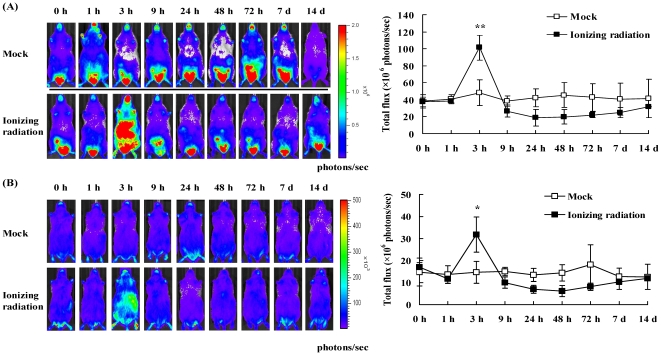
NF-κB-dependent bioluminescence in living mice.Transgenic mice were exposed to ionizing radiation and imaged in ventral (A) and dorsal positions (B) at indicated periods. In vivo imaging was shown on the left panel. The color overlay on the image represents the photons/sec emitted from the animal, as indicated by the color scale. Photos are representative images (n = 10). Quantification of photon emission from the whole animal was shown on the right panel. Shown is the total photon flux plotted over time. Values are mean ± standard error (n = 10). * p<0.05, ** p<0.01, compared with mock.